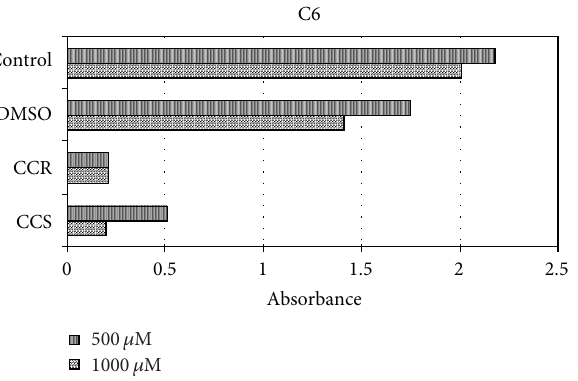
F 3: Antiproliferative effect of CCS and CCR to the C6 cells.